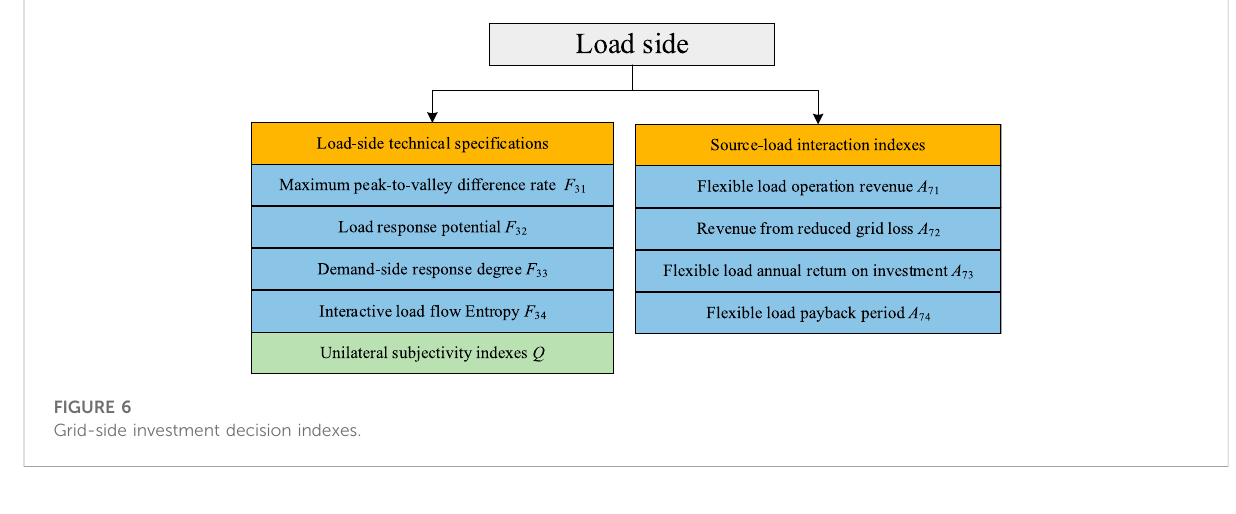
FIGURE 6 Grid-side investment decision